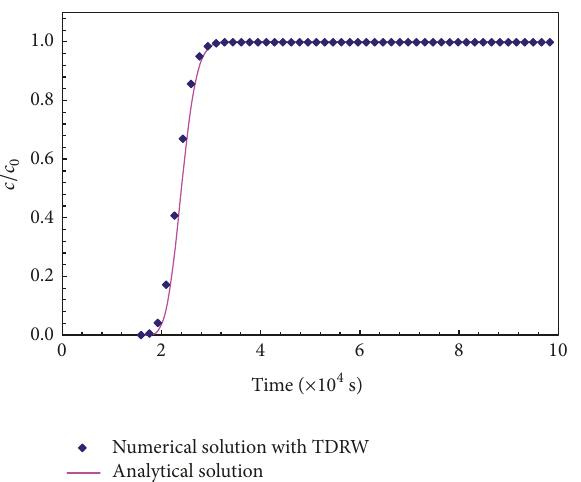
Figure 5: Comparison between numerical and analytical solutions for nuclide particle transport in a single fracture.